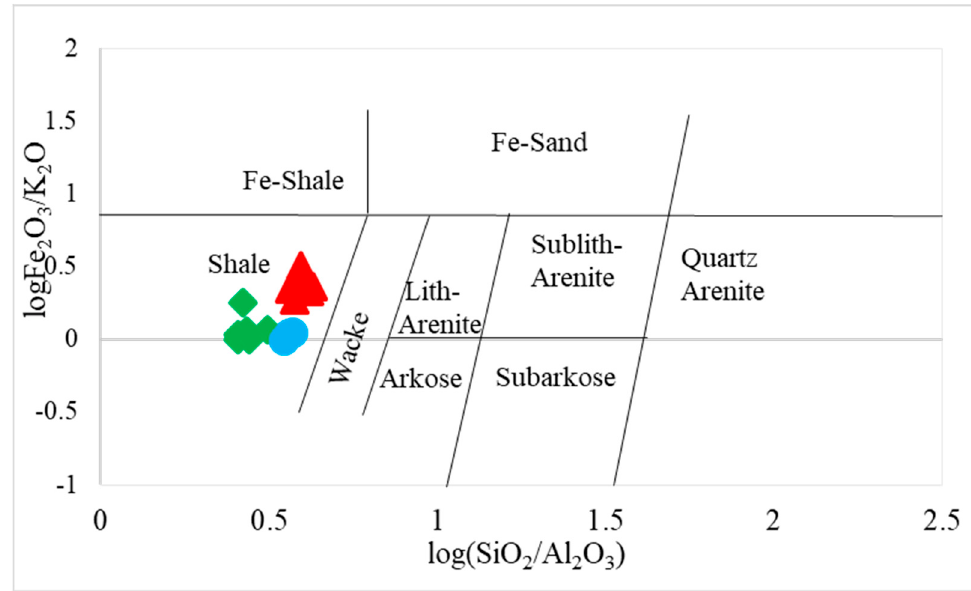
Figure 14. Classification of siliciclastic rocks.